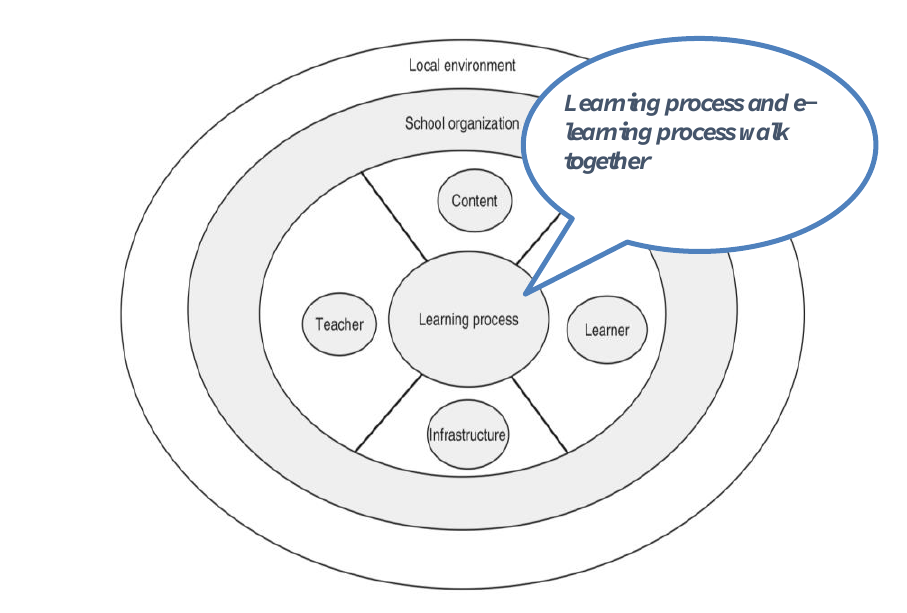
Fig. 2. E-learning process as part of Learning Process. [4] adapted by the